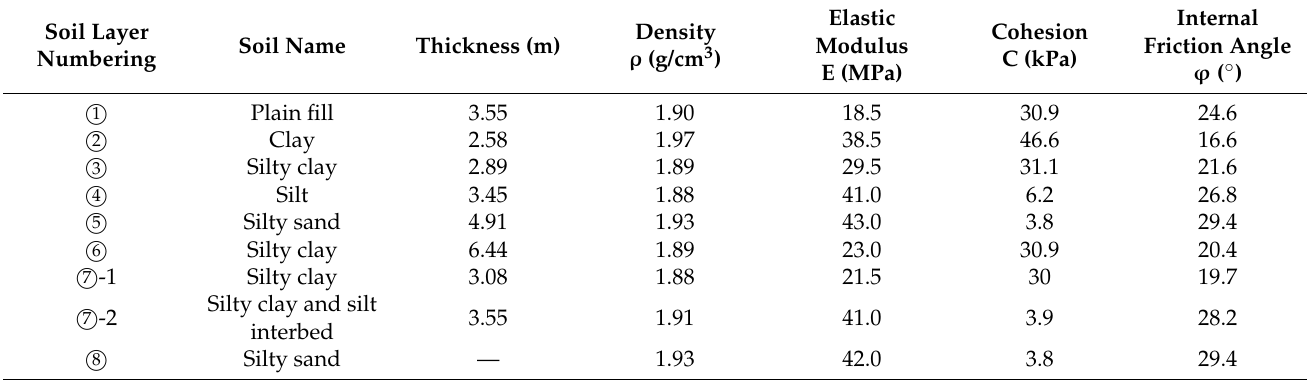
Table 1. Physical and mechanical properties of soil.